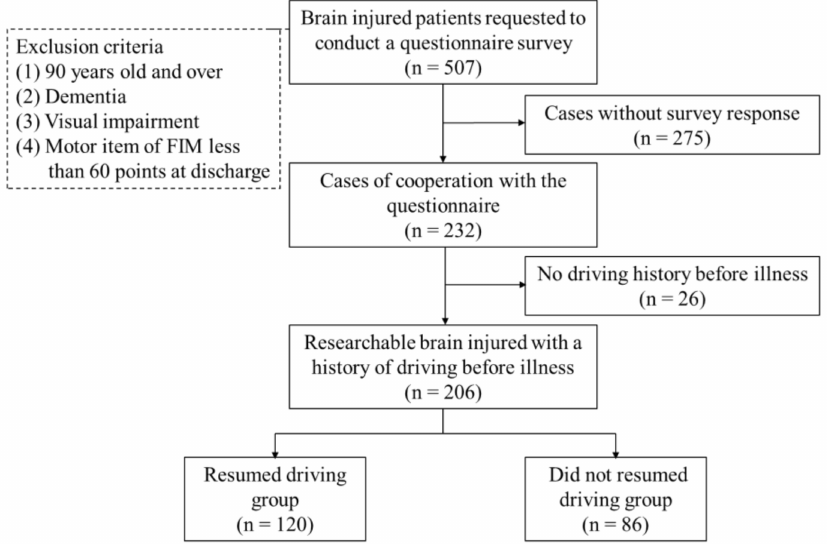
Figure 1. Flowchart of the study selection.